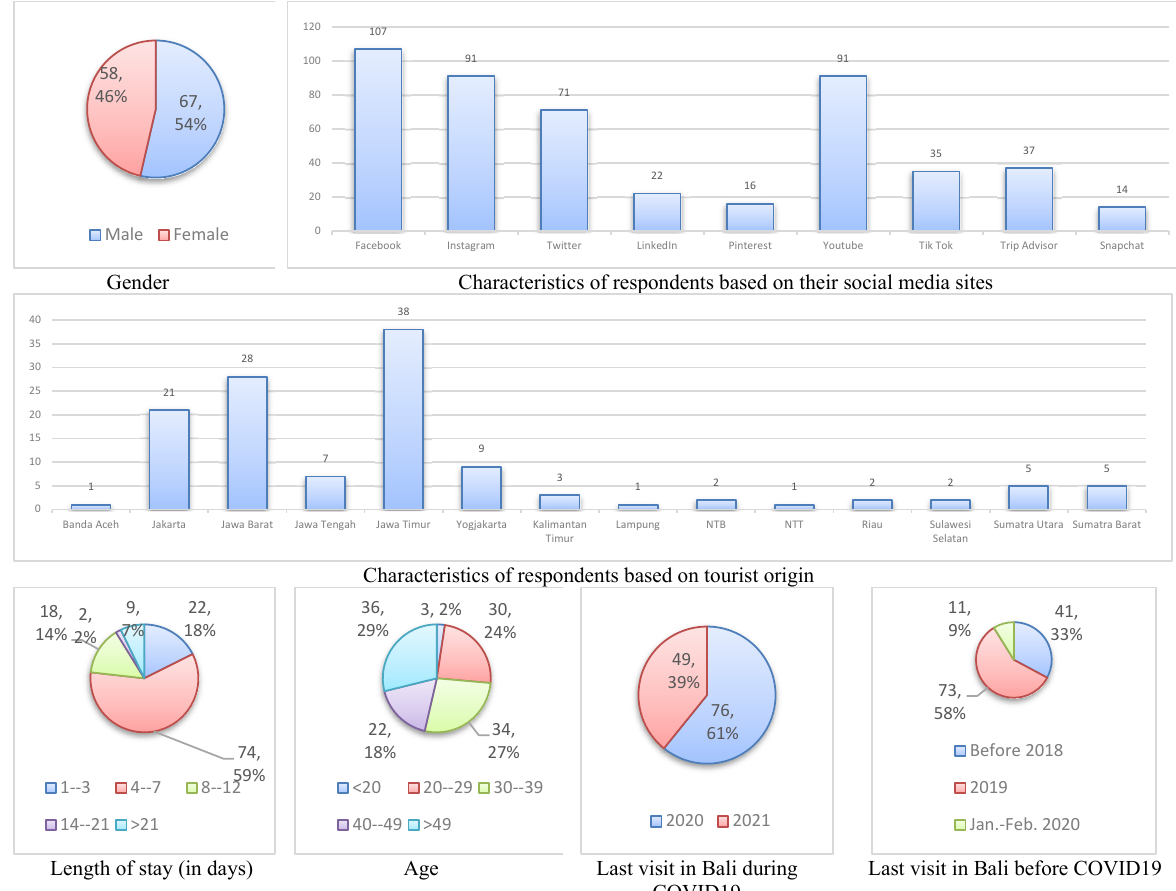
Fig. 1. Characteristics of respondents